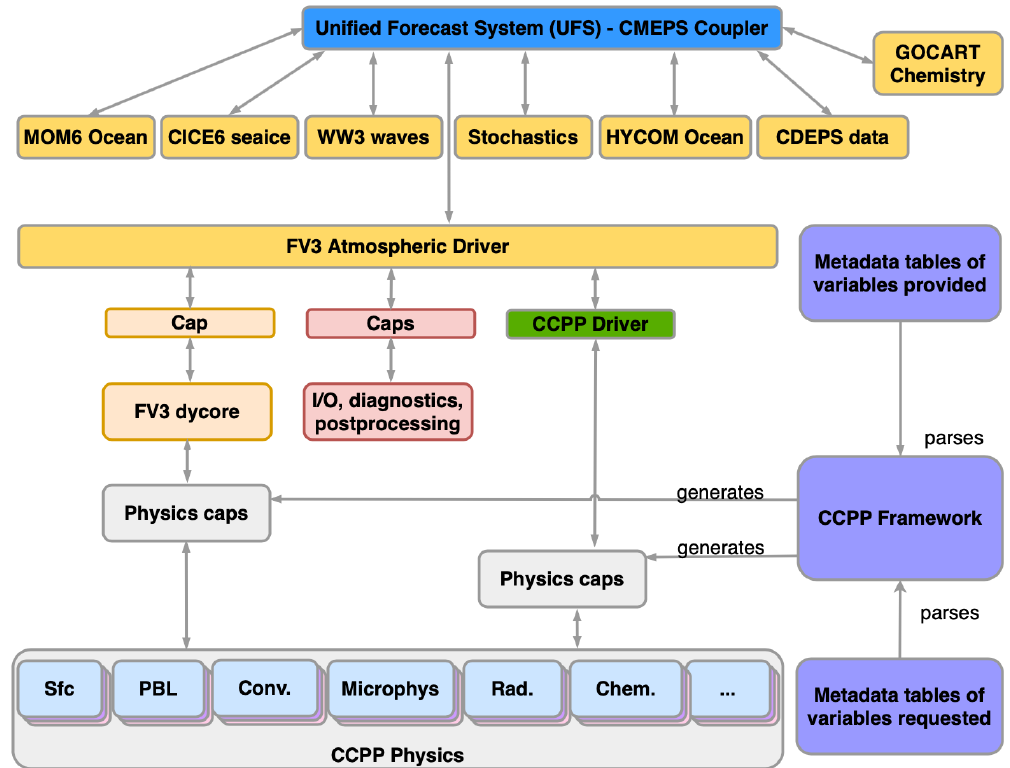
Figure 6. Schematic representation of the integration of the CCPP in the